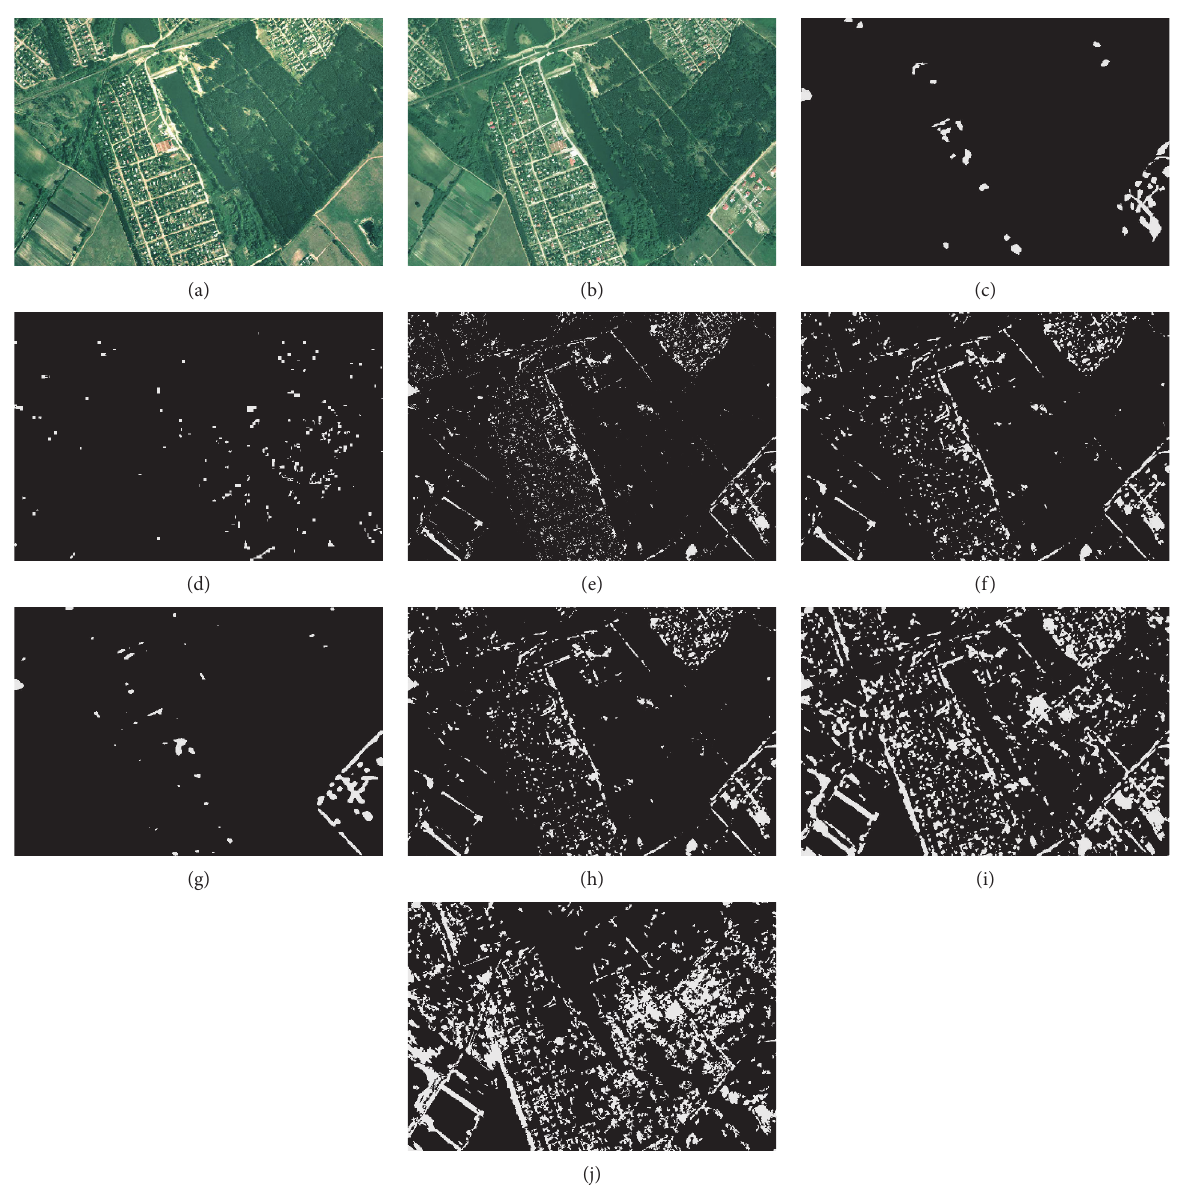
Figure 3: Visual comparison of change detection results in the second group of experiments. (a) Image 1. (b) Image 2. (c) Reference